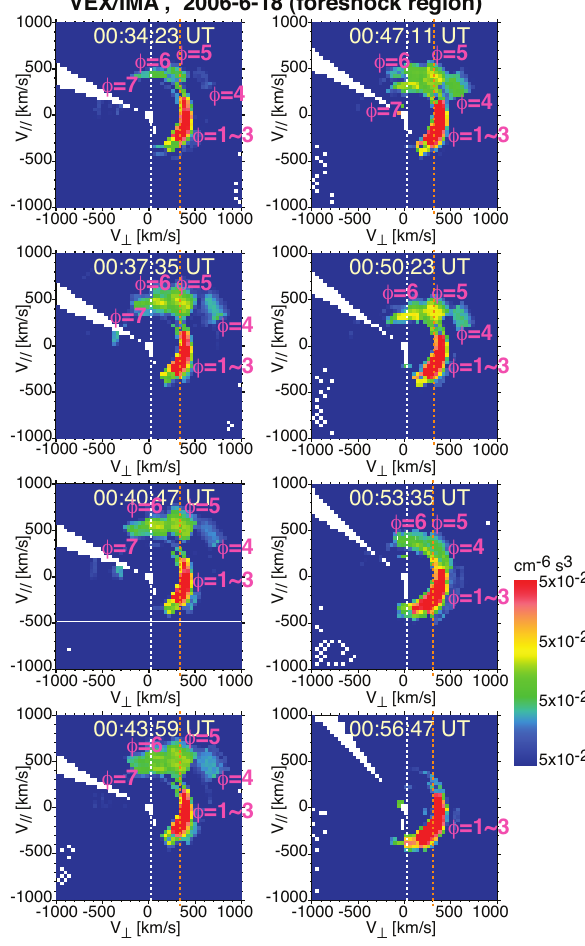
Fig. 5. Velocity-space distribution function ( V ⊥ and V k axes, where ⊥ and k denote perpendicular and parallel directions with respect to the magnetic field) for the eight scans (192s cycle for each scan) shown in Fig. 4 (00:34:23 ∼ 00:59:59UT). Each panel shows a 2-D projection of the 3-D distribution function, where this 2-D plane is defined by the magnetic field direction and the solar wind flow di- rection. Therefore, the dashed vertical red lines denote the perpen- dicular velocity of the solar wind ( V SW ⊥ ), and this is the V k axis in the solar wind reference frame. The corresponding IMA look direc- tions are θ = 7 ∼ 9 at φ = 5 and θ = 7 ∼ 8 at φ = 1 (marked by empty orange squares in Fig. 4). The dashed vertical white lines denote V ⊥ = 0 in the spacecraft frame, and the corresponding IMA look directions are θ = 6 ∼ 8 at φ = 6 ∼ 7 and θ = 7 ∼ 9 at φ = 14 ∼ 15 (marked by filled red squares in Fig. 4). Its opposite phase point in the solar wind reference frame corresponds to φ = 4. The separa- tion of the peaks between neighboring azimuthal sectors (between φ = 4, φ = 5, and φ = 6) is most likely real because the registered energy in Fig. 4 is quite different between these